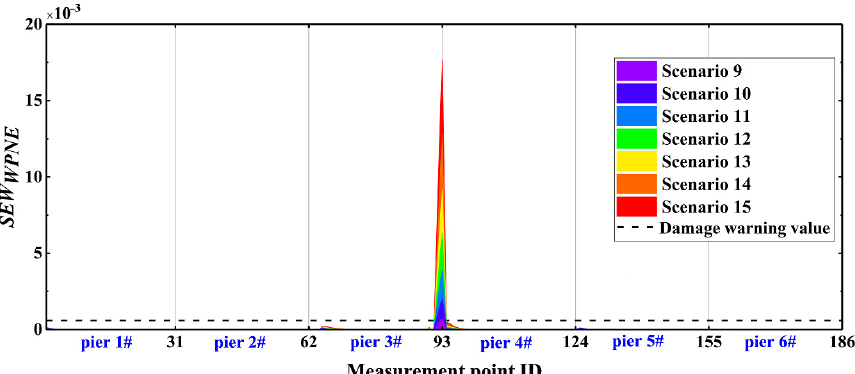
Figure 14. SEW WPNE identification results of damage II of 6 bridge piers.